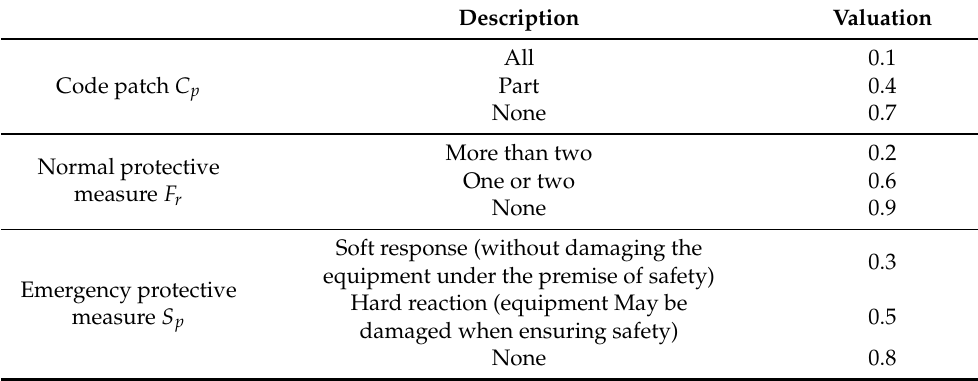
Table 4. Safety protection value.